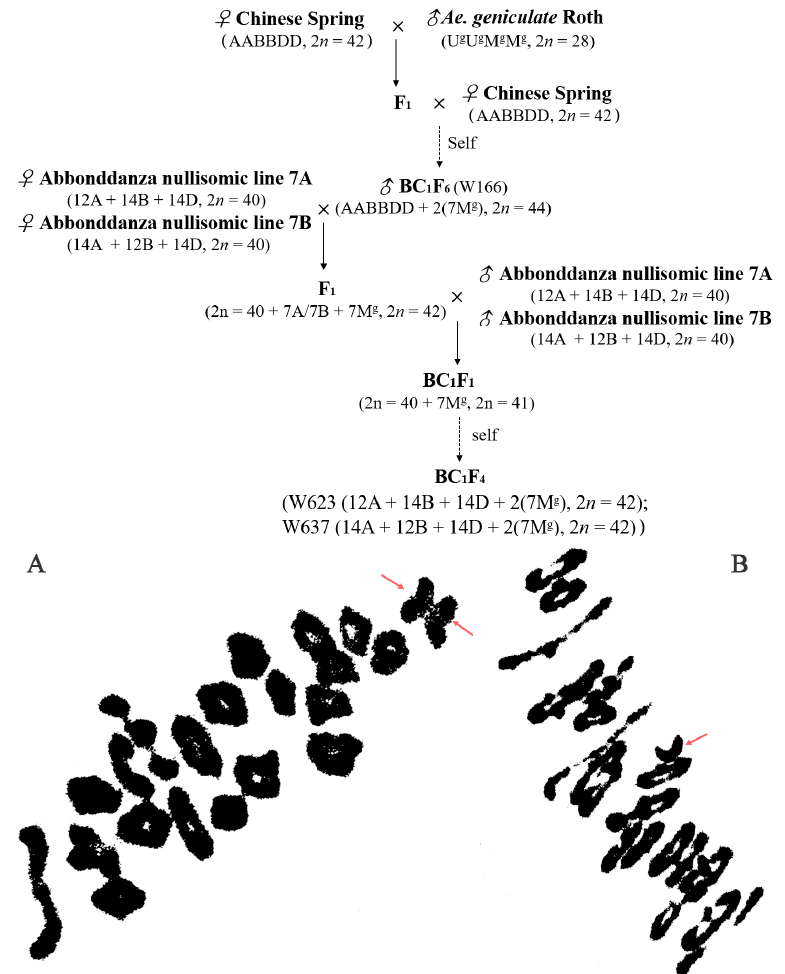
Figure 7. A crossing program showing strategies employed to generate wheat- Ae. geniculata substi- tution lines and cytogenetic analysis of interspecific hybrids. ( A ). pollen mother cell chromosomal configurations of F 1 originated from the crossing between Abbondanza nullisomic lines and W166 at meiotic metaphase I: 2 n = 20II + I + I ( B ). pollen mother cell chromosomal configurations of BC 1 F 1 originated from the crossing between F 1 and Abbondanza nullisomic lines at meiotic metaphase I: 2 n = 20II + I. The red arrow indicated univalent